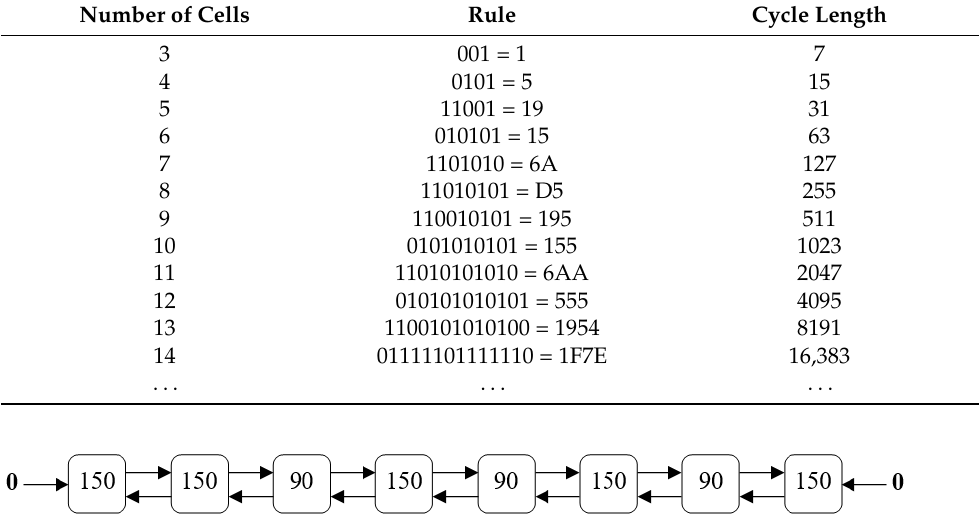
Figure 2. Example of 8-bit LHCA with 90/150 rules.